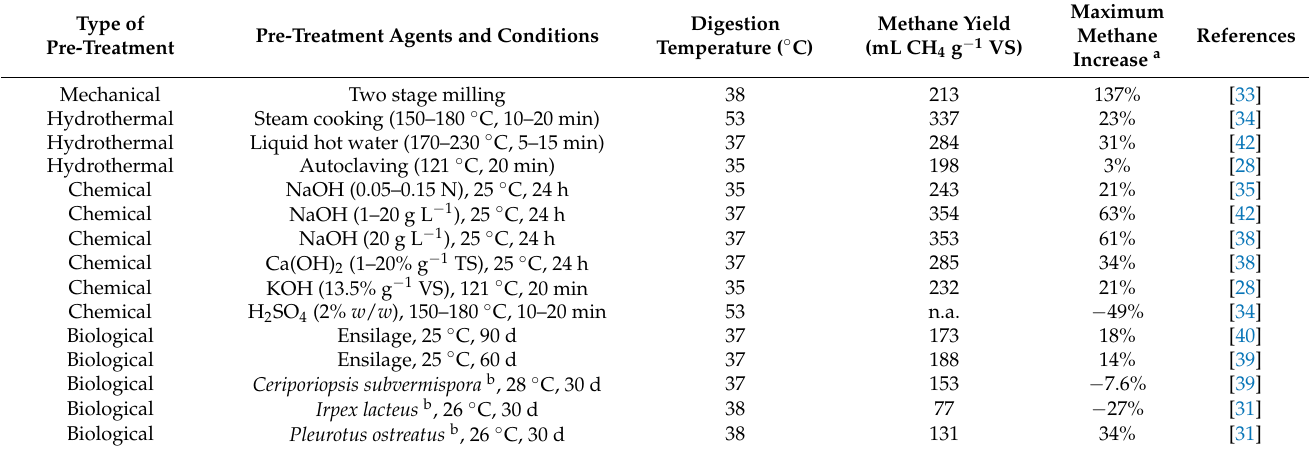
Table 2. Effects of different pre-treatments of giant reed biomass on methane yield in batch